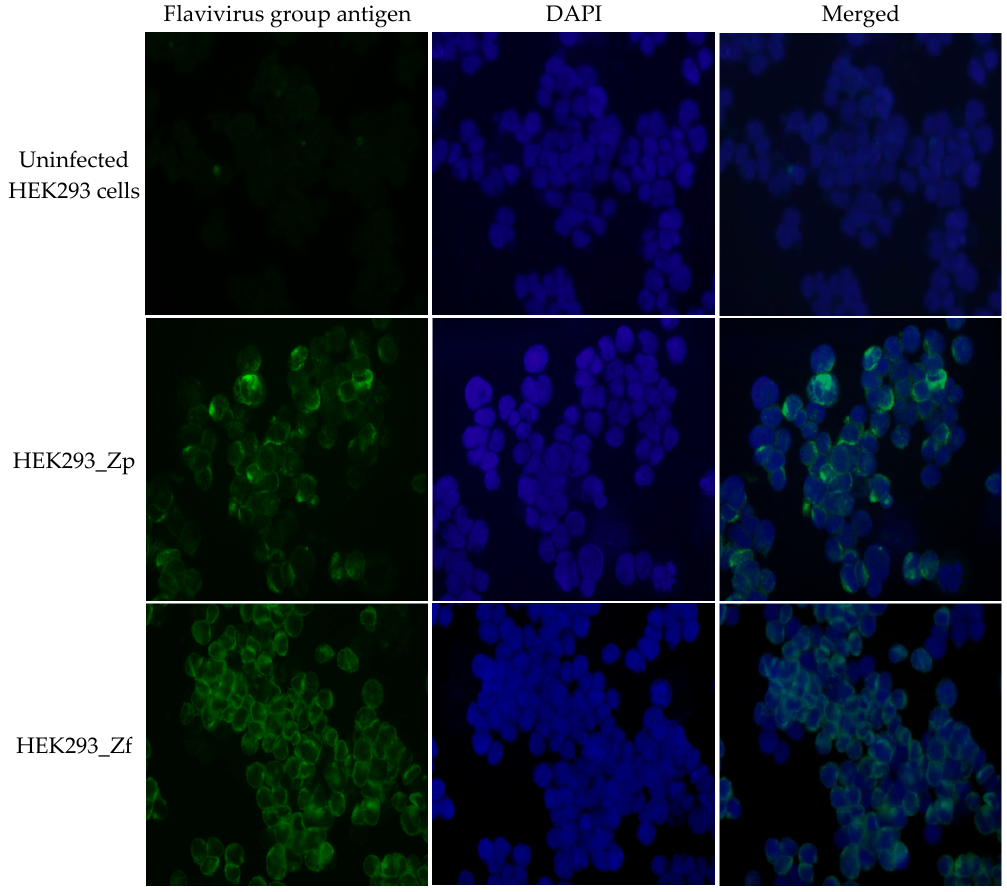
Figure 2. IFA (immunofluorescence assay) of ZIKV-specific antigen in non-ZIKV-infected HEK293 control cells and the monolayer HEK293 cells re-established in PRV strain ZIKV-infected culture (HEK293_Zp) or HEK293 cells re-established in FLR strain ZIKV-infected culture (HEK293_Zf). Cells in the monolayer cultures were trypsinized and dotted onto cover slides before IFA staining.